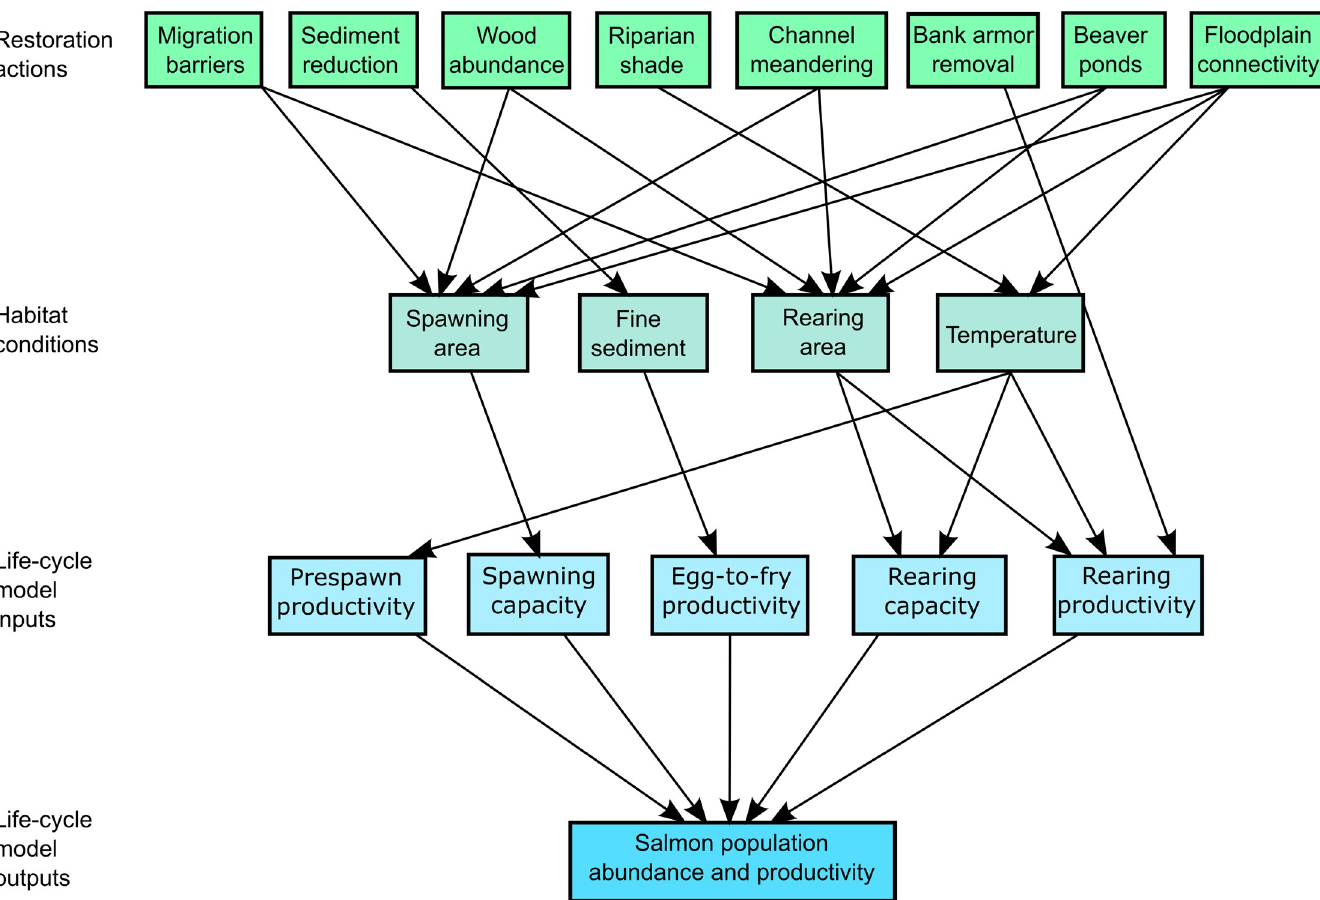
Fig 1. Conceptual model. Diagram of model linkages between restoration actions, habitat conditions, life-cycle model input parameters, and salmon population response.